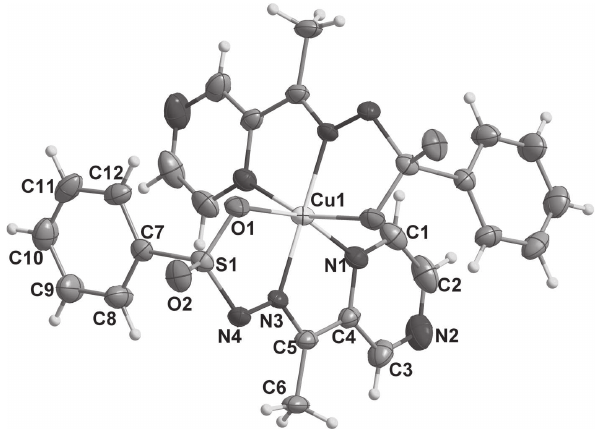
Table 1: Data collection and handling.